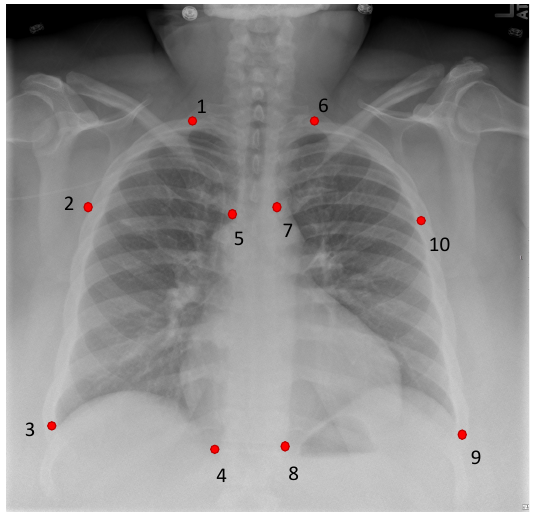
Figure 5. Our proposed CXR landmarking scheme. There are 10 keypoints defined in our landmark- ing